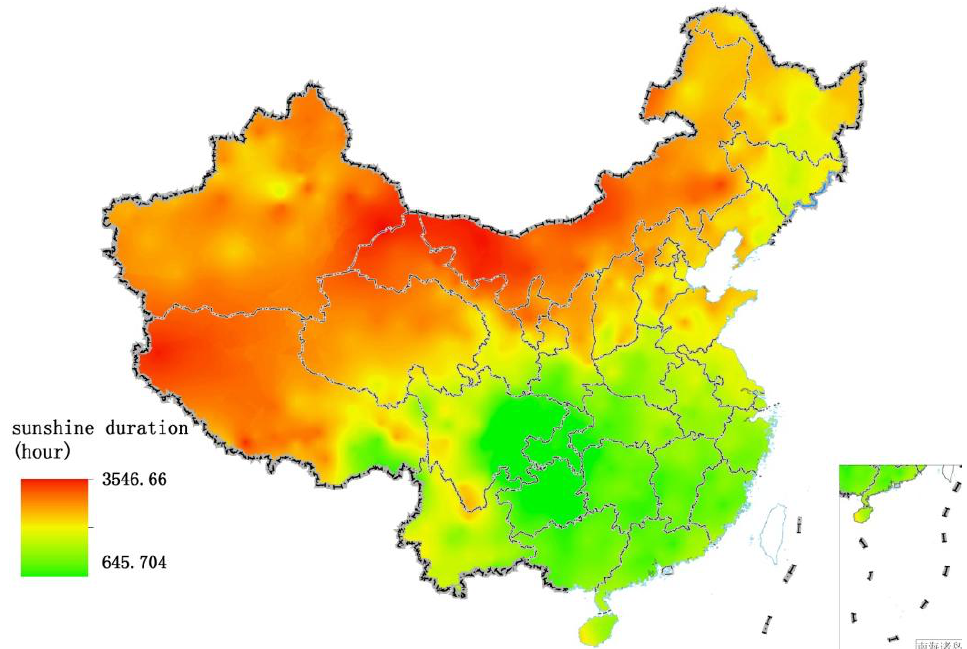
Figure 7. Spatial distribution of sunshine duration over China in